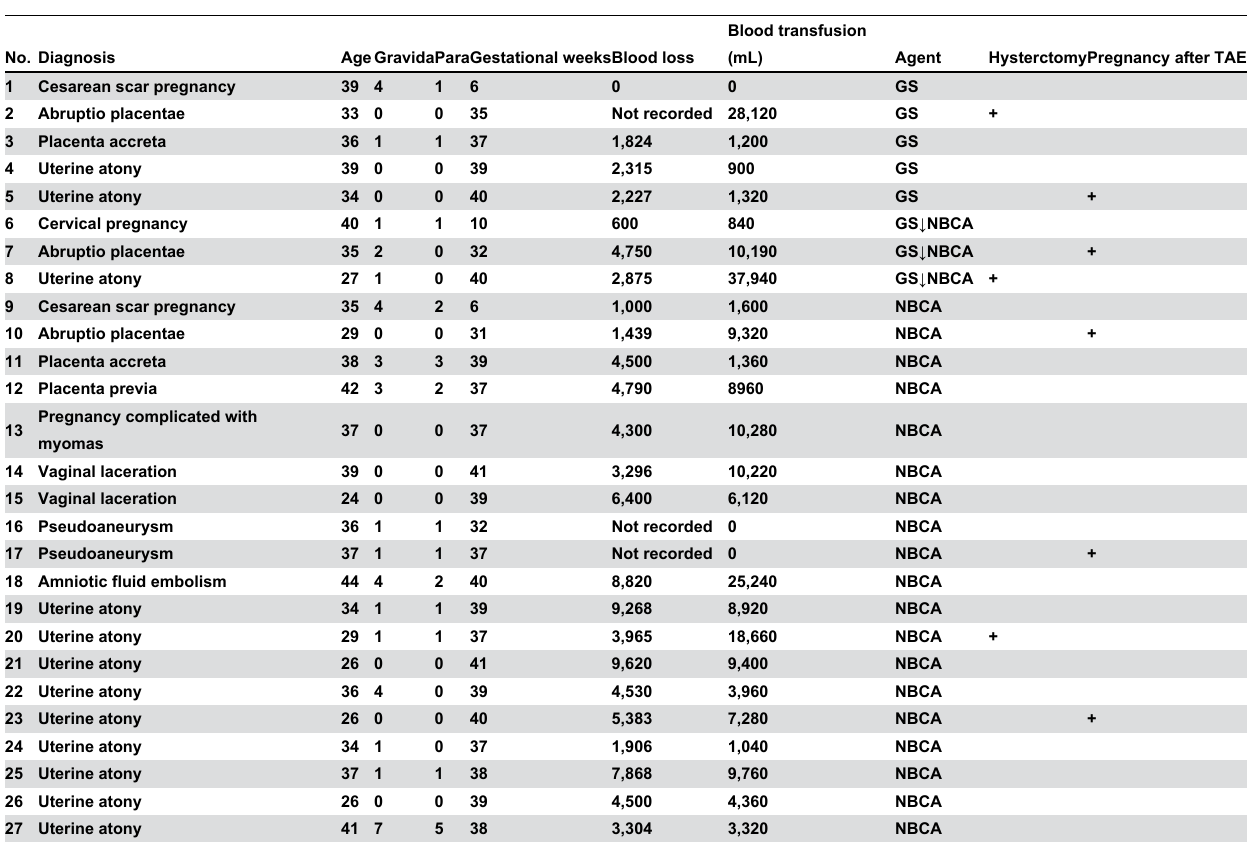
Table 2. All cases in which TAE was performed in pregnant